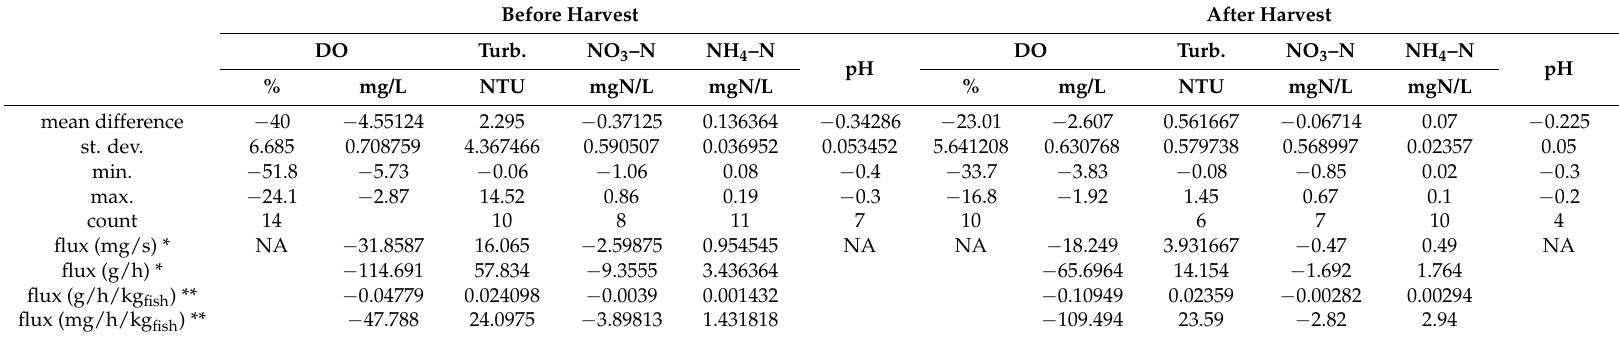
Table 5. Summary of the 1 13 pond differential data and fluxes between outlets and inlet before and after